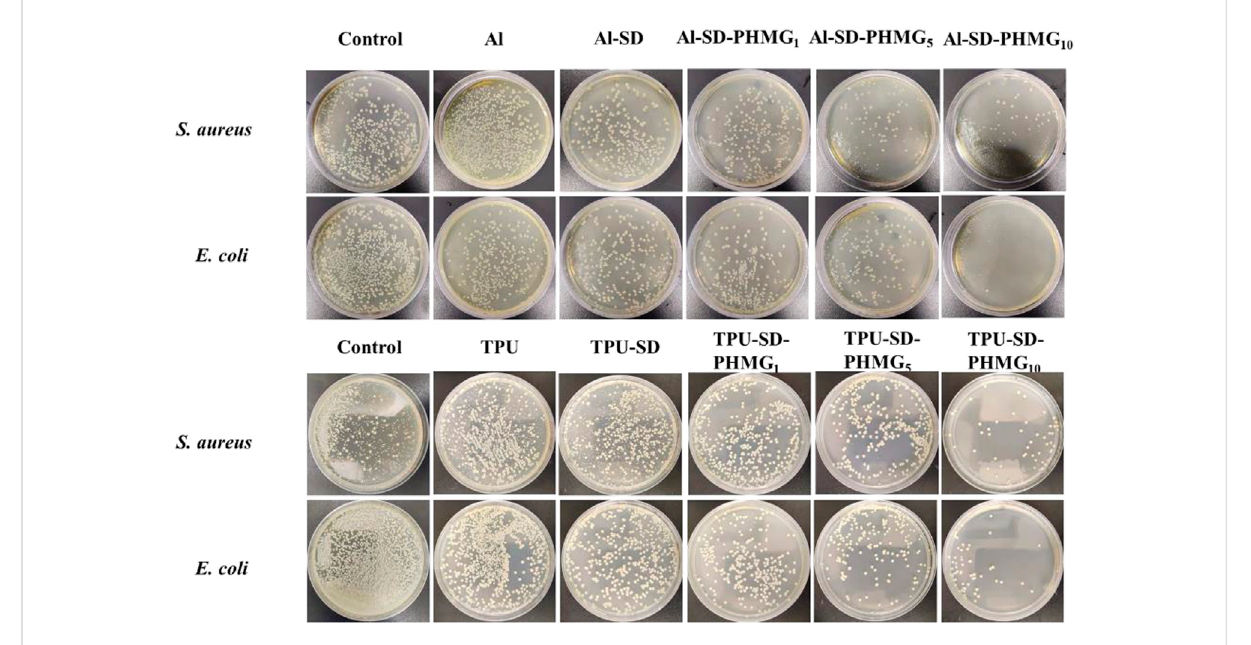
FIGURE 7 Antibacterial results of the coated Als and coated